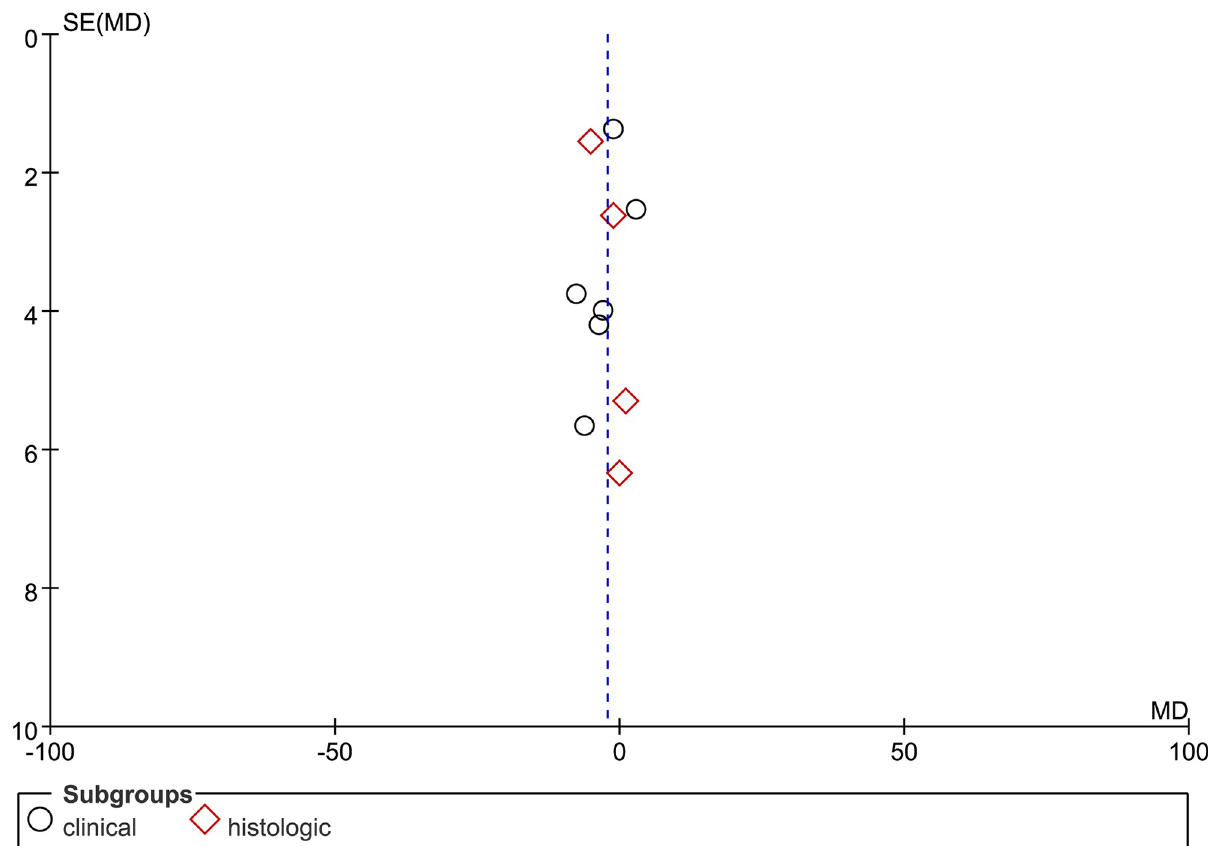
Fig 4. The funnel plot for publication bias test. Funnel plot with pseudo 95% CI of MDI.